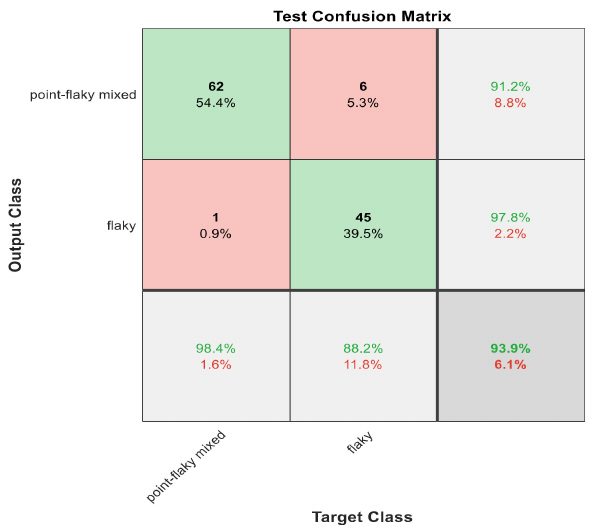
Figure 19. The confusion matrix for Model 2 using 1000 deep learning features.